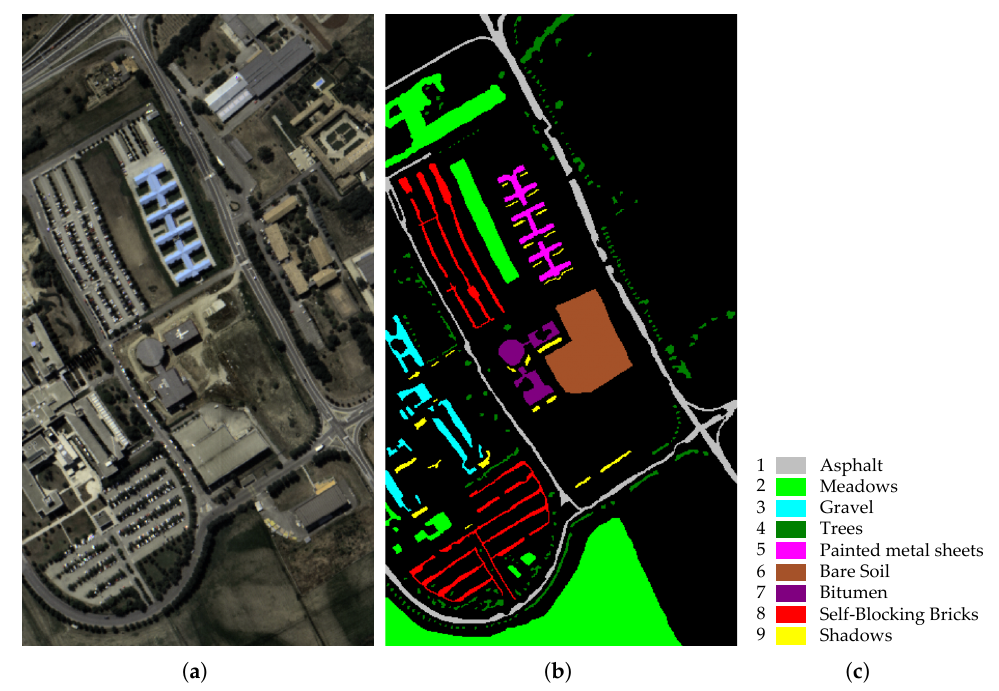
Figure 7. The Pavia University dataset. ( a ) The false-color image. ( b ) The ground-truth map. ( c ) The corresponding color labels.